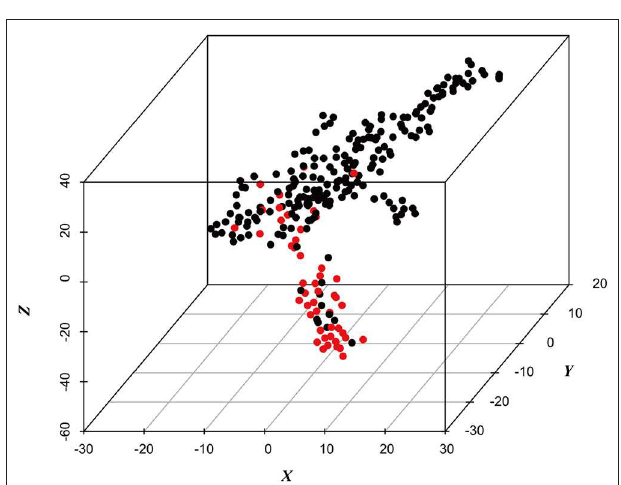
FIGURE 2 | Visualization of the metabolic data set computed by t-SNE. Red signifies classification as positive, and black signifies classification as negative.